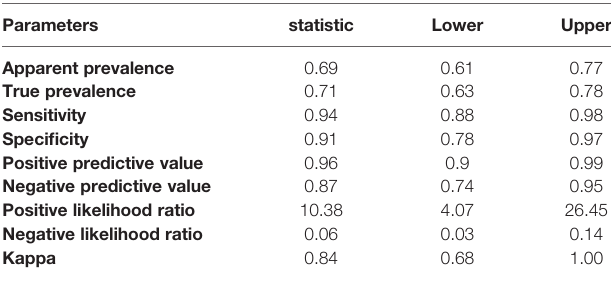
TABLE 3 | Summary and statistical parameters, considering cutoff 4.8 for the chimeric antigens IBMP-8.1 and IBMP-8.4, con fi dence interval (95% CI).